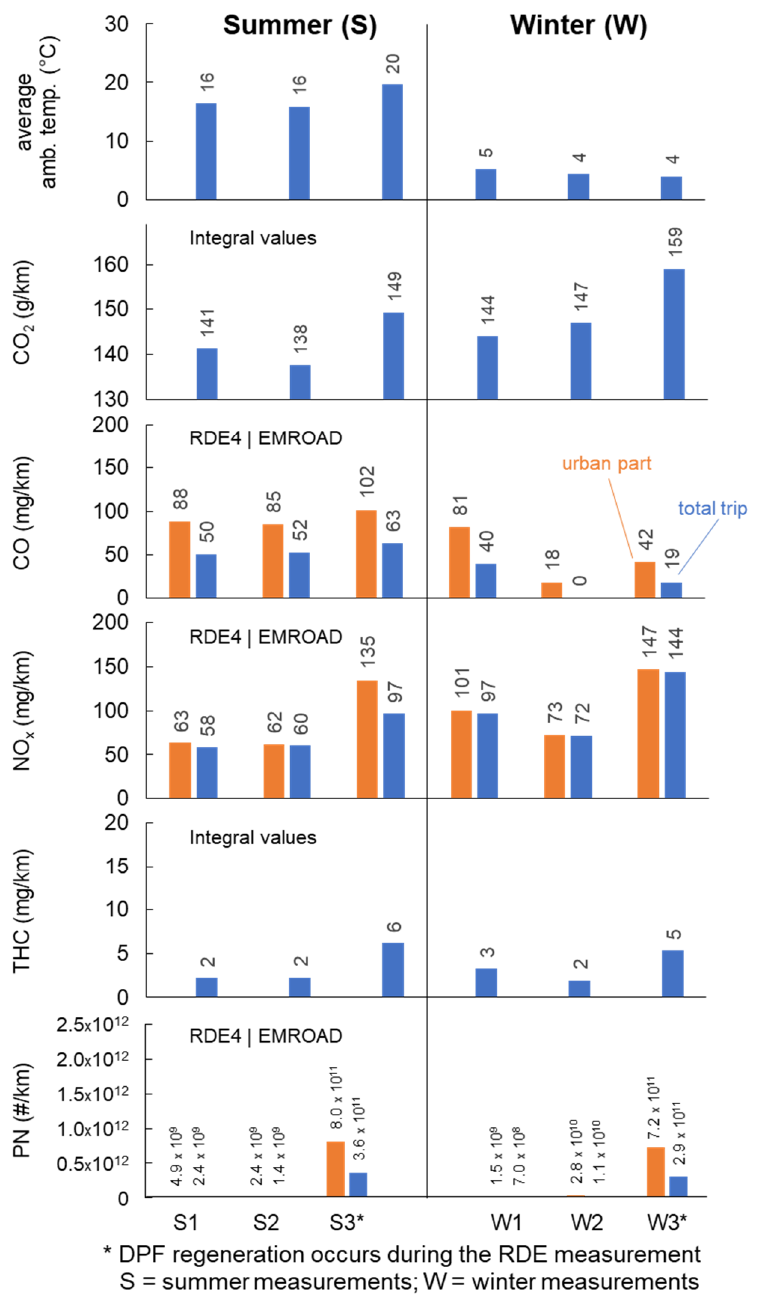
Figure 4. Comparison of real driving emissions in summer and winter conditions, official RDE route, integral average values, vehicle 2, diesel.